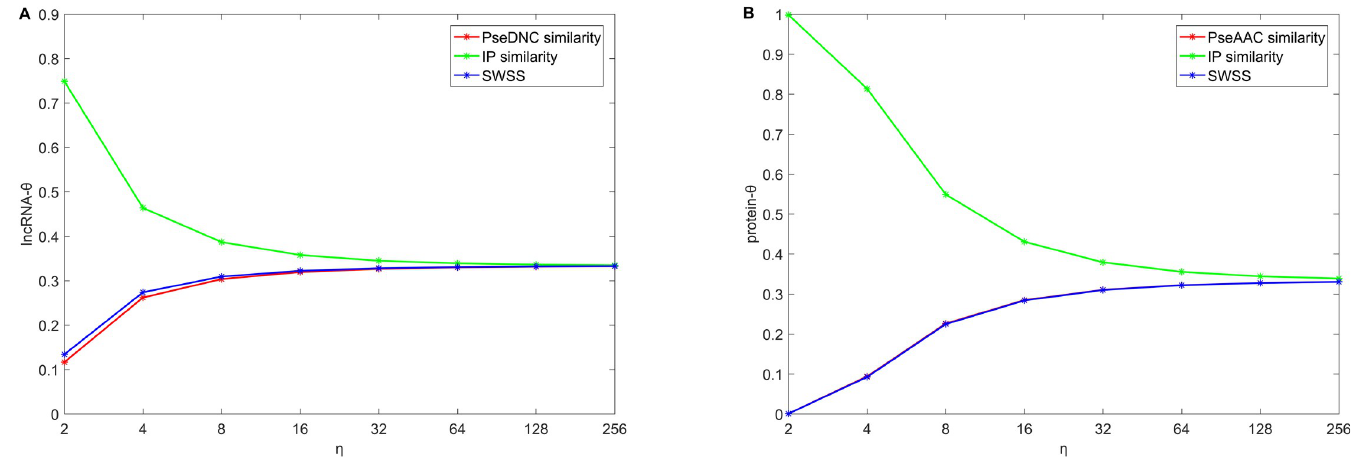
Fig 3. (A) The relationship between η and θ